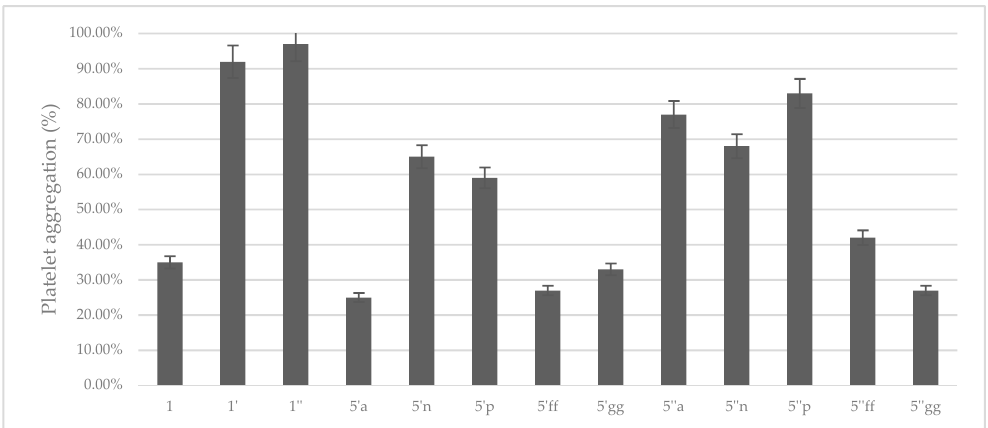
Figure 4. Antiplatelet aggregation activity activities of the 10-substituted 1,2,3-triazole-ginkgolide A and ginkgolide C derivatives. Ginkgolide B ( 1 ), ginkgolide A ( 1’ ) and ginkgolide C ( 1’’ ) were used as reference.